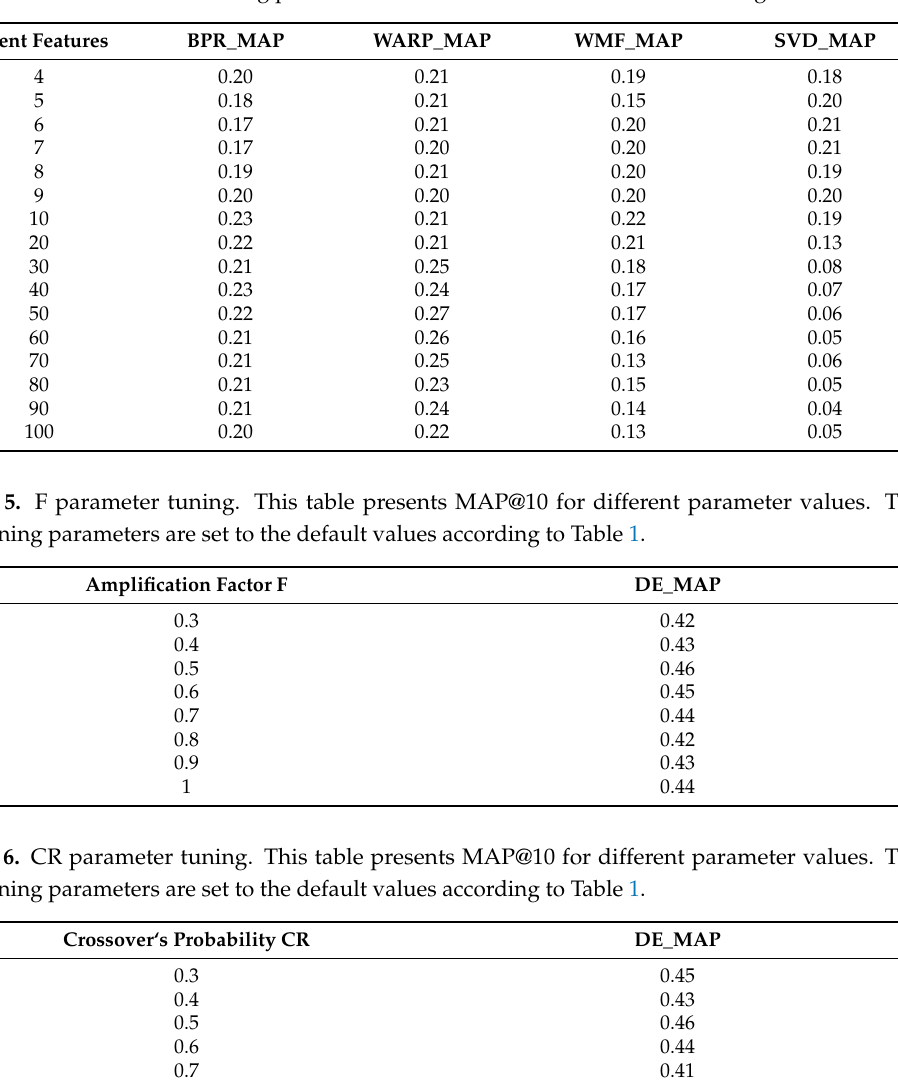
Table 4. Latent features (dimensions) parameter tuning. This table presents MAP@10 for different parameter values. The remaining parameters are set to the default values according to Table 1.